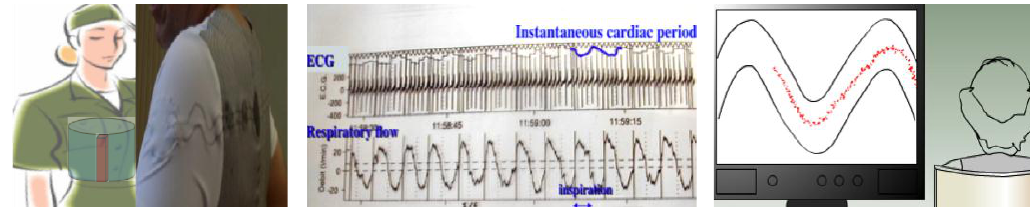
Figure 1. Left: thoracic smart textile devices; Middle: monitoring the integrity of the cardiopulmonary bulbar controller, showing the persistence of the respiratory sinus arrhythmia; Right: recording the cardio-respiratory system through the thoracic device Visuresp ® and visualization of the actual rhythm (red) inside the “viable” tube (black) to be regarded for getting a physiologic respiration during rehabilitation.